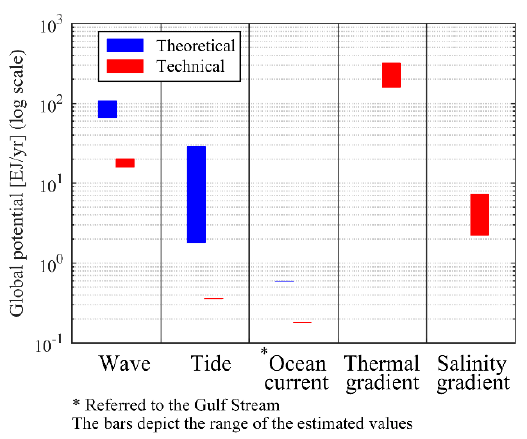
Figure 3. Summary of the global ocean renewable energy resources.